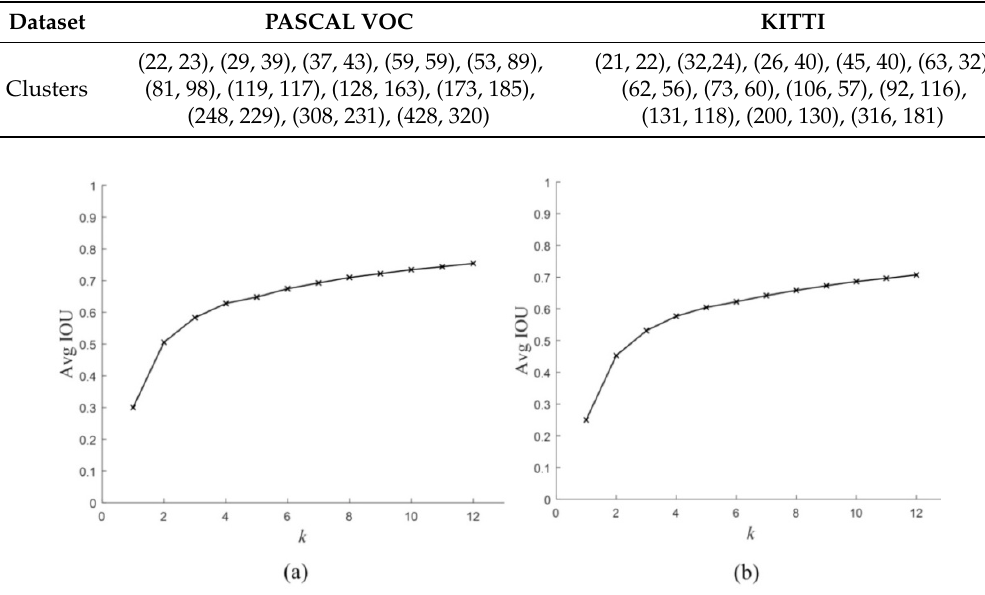
Figure 3. K-means clustering analysis result. ( a ) KITTI dataset; ( b ) PASCAL VOC.